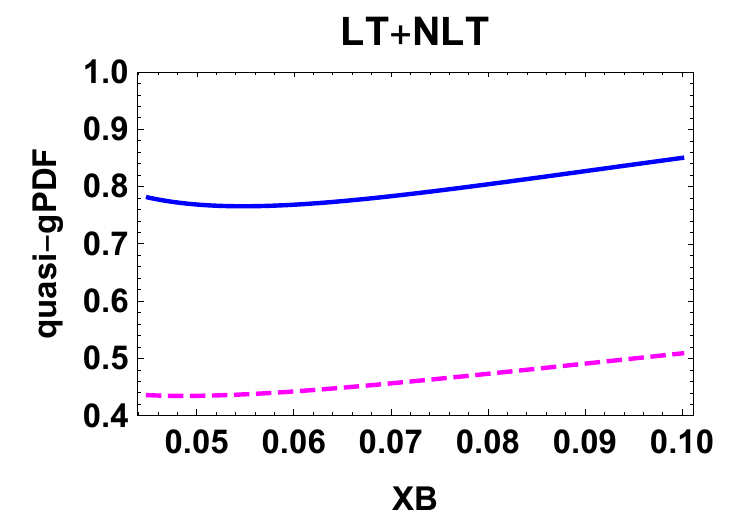
2 2 B ξ x Q 2 s